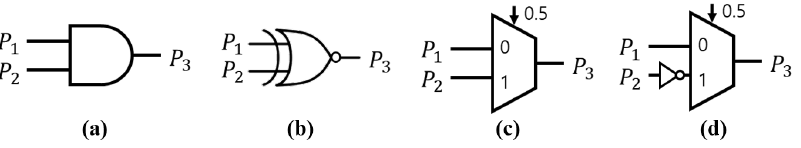
Figure 4. Stochastic computing circuits; ( a ) Stochastic uni-polar multiplier ( b ) Stochastic bipolar multiplier ( c ) Stochastic adder ( d ) Stochastic subtractor.